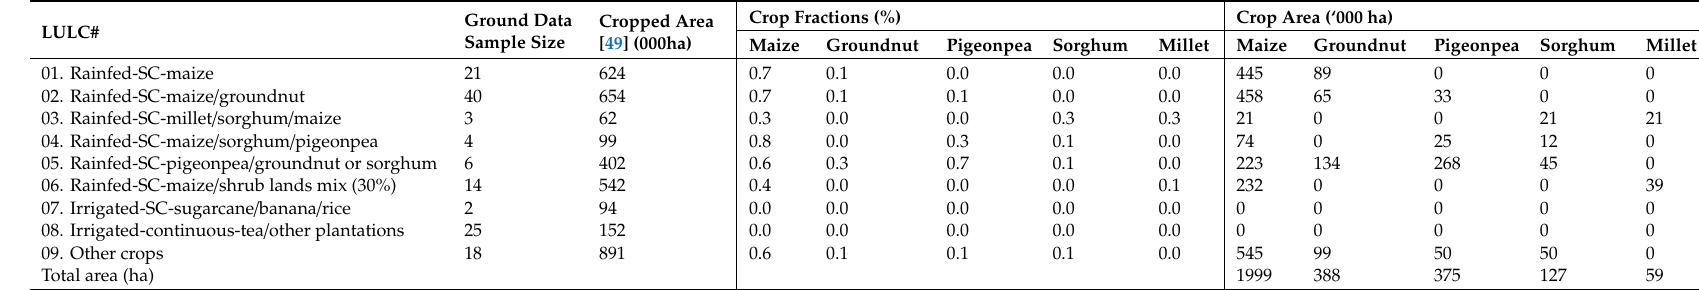
Table 5. Cropland area for each class, providing an understanding of sub-pixel fractions for the five important crops in Malawi for the crop year 2016–2017.